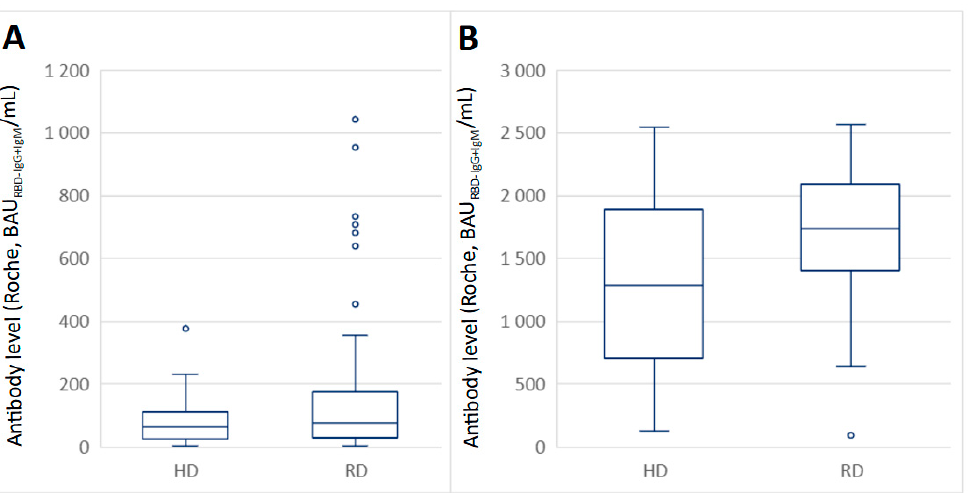
Figure 3. Boxplot (median, hinges: first and third quartiles, whiskers: the largest value no further than 1.5 * IQR from the hinge) showing humoral response to the vaccination as measured with antibody levels in the RD- and HD-COVID-19- negative subgroups on the day of the second dose (FD: n = 152, HD: n = 33; ( A ) and 8–10 days after the second dose for participants whose results were within the test detection limit (FD: n = 45, HD: n = 14; ( B )).